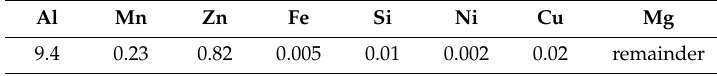
Table 1. Nominal composition (wt %) of AZ91D magnesium